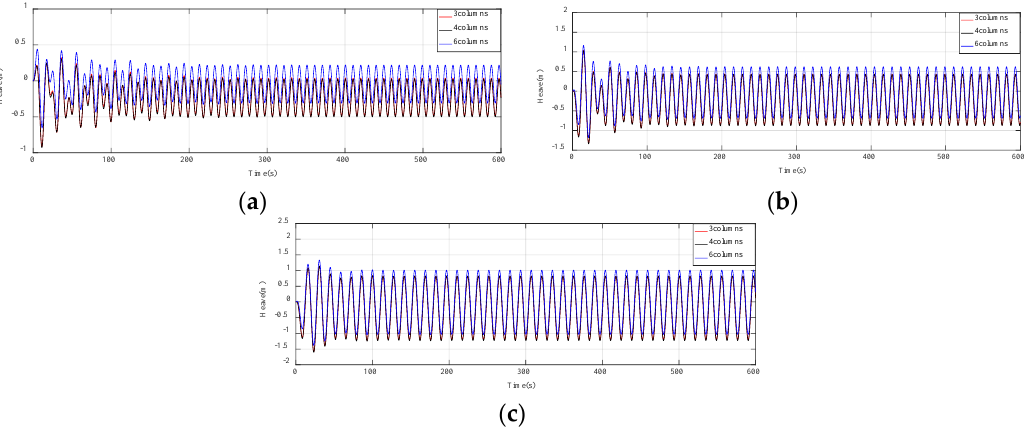
Figure 10. Heave response curves for all three platforms under wave loadings ( a ) LC1, ( b ) LC2, and ( c ) LC3.